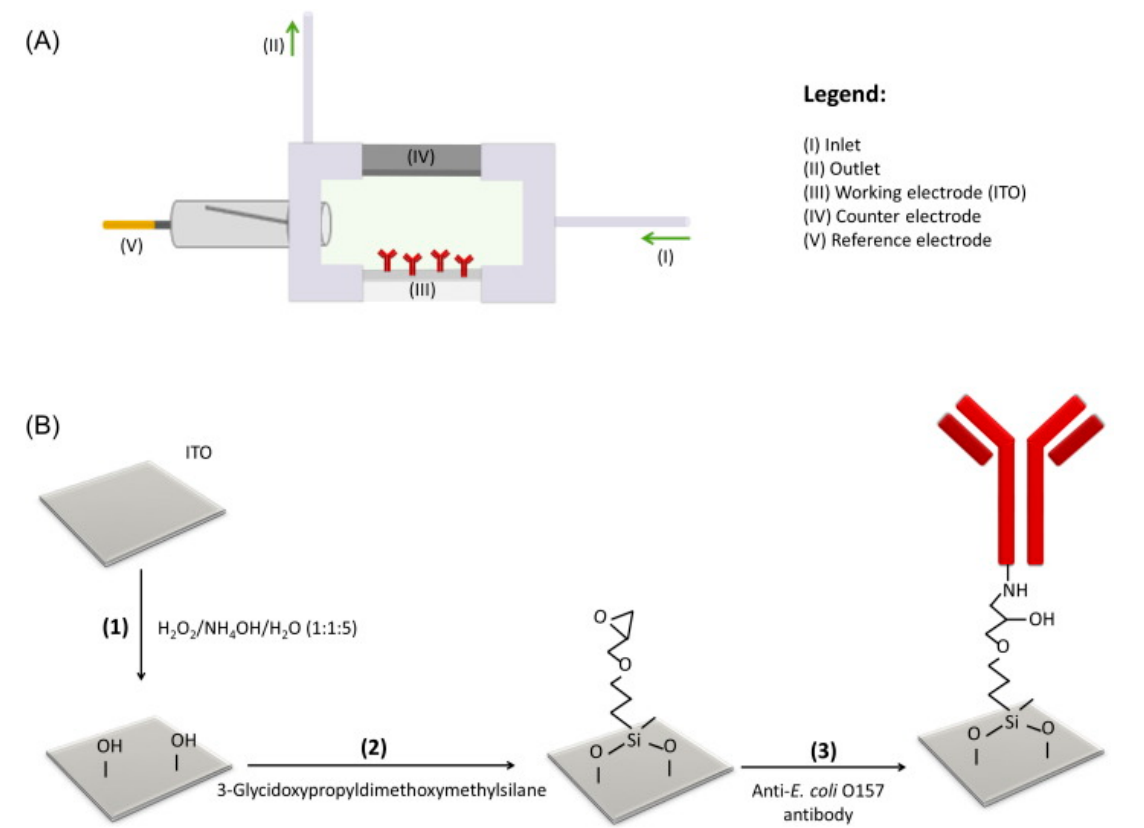
Figure 3. Schematic illustration of electrochemical cell ( A ) fabrication of immunosensor ( B ): hydroxylation (1), silanization (2), and antibody binding (3) [62] .